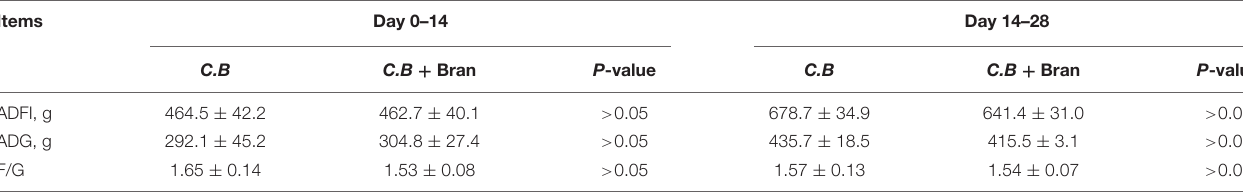
TABLE 2 | Effect of dietary C.B and C.B + corn bran inclusion on weaned pigs growth performance 1 . Items